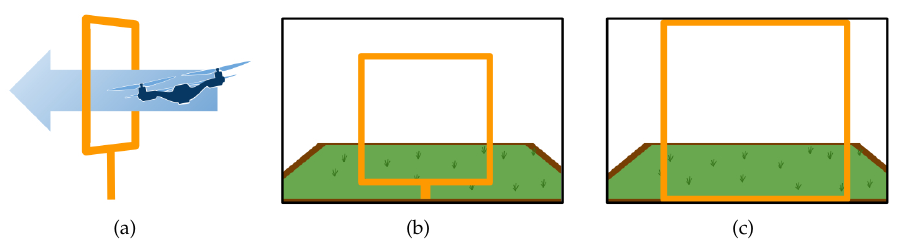
Figure 6. Schematic drone’s forward motion: ( a ) outside view of the corresponding forward motion when the gate appears in the image center ( b , c ). The flight command θ will take values in the range of [ 0,1 ] ; values for ( φ , ψ , h ) will be set to zero.